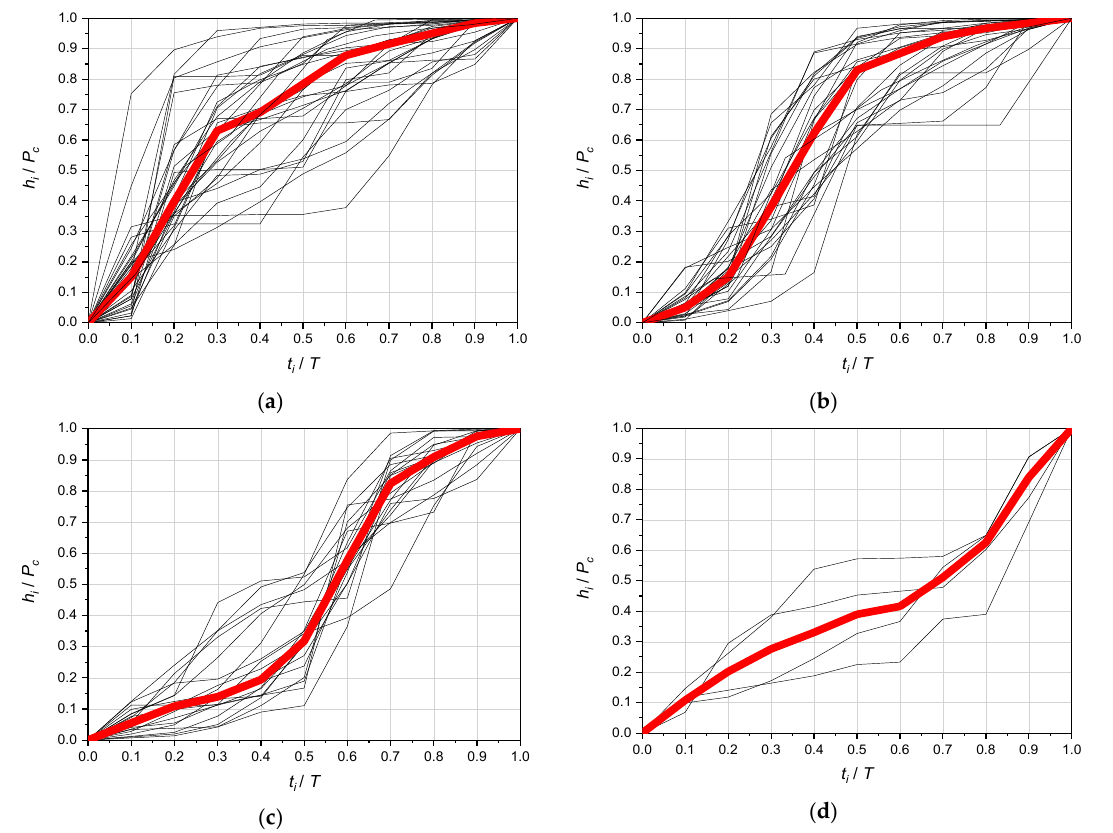
Figure 5. Dimensionless rainfall curves with a median curve for 4 Huff quartile groups: ( a ) I quartile, ( b ) II quartile, ( c ) III quartile, and ( d ) IV quartile.